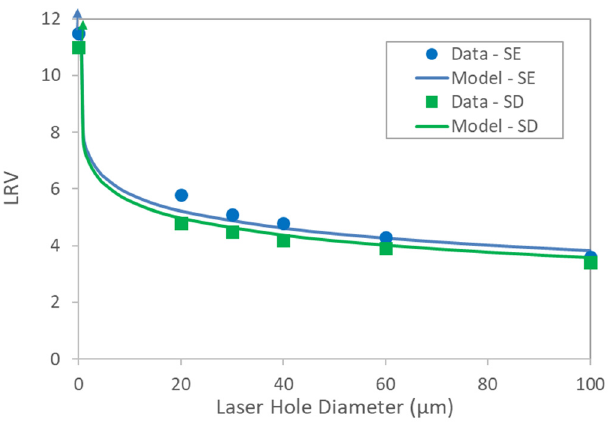
Figure 10. Effect of laser hole defect size on bacterial retention. Arrows indicate that no bacteria were detected in the filtrate.